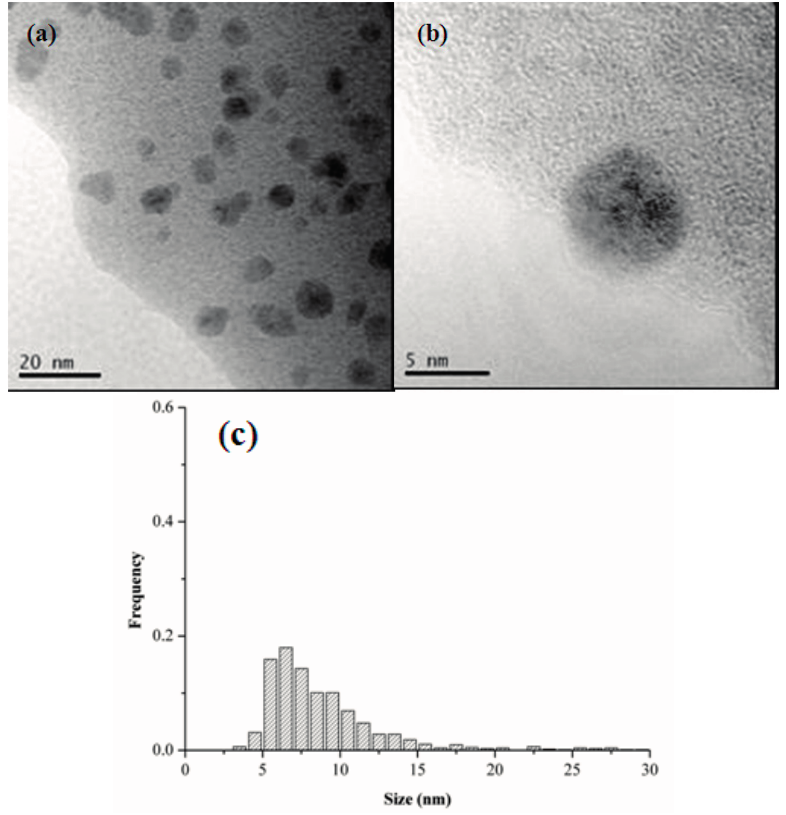
Figure 10. ( a , b ) TEM images and ( c ) Pd NPs particle size distribution of Pd-pol used in the nitrobenzene reduction under hydrogen at room